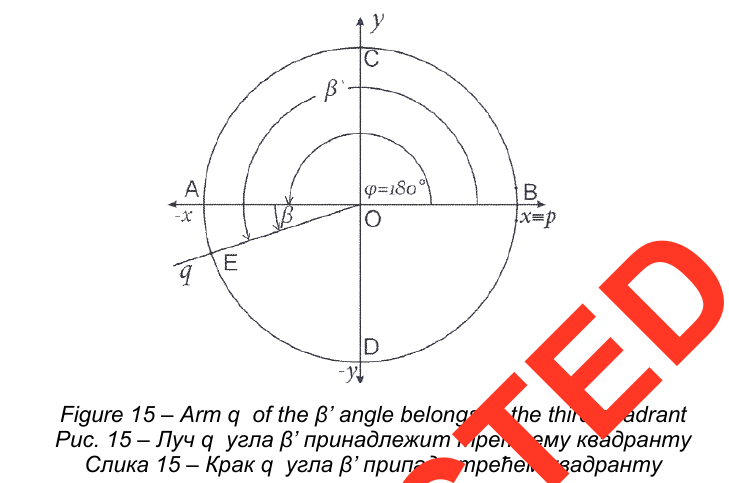
Figure 15 – Arm q of the β ’ angle belongs to the third quadrant